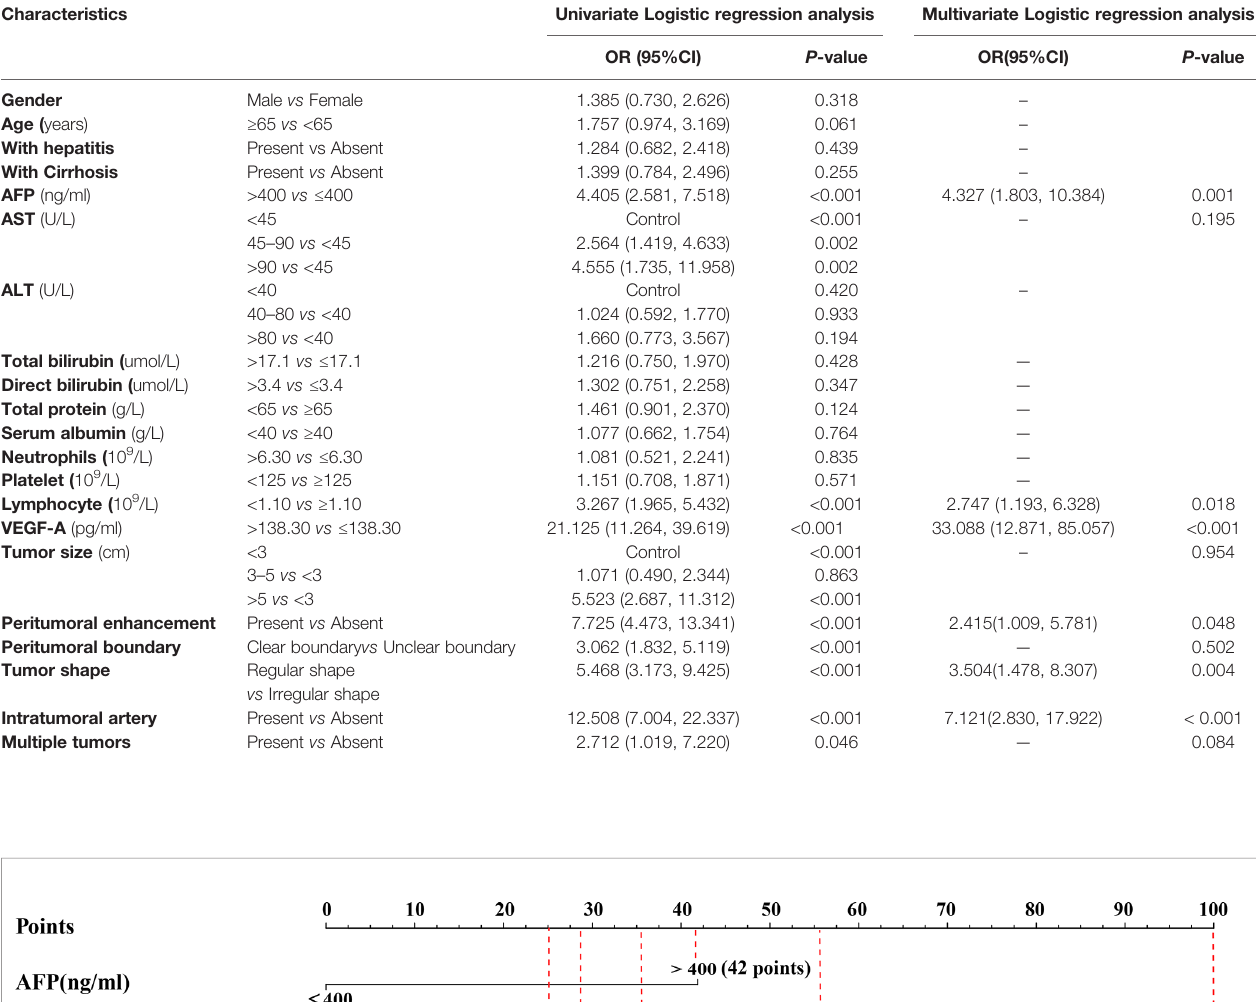
TABLE 2 | Univariate and multivariate logistic regression analysis of prediction of MVI in training